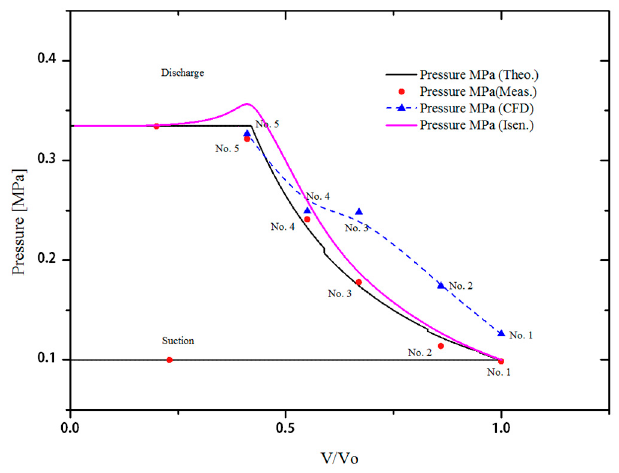
Figure 16. Comparison results of pressure distribution between the theoretical values, CFD and measurements on the p-V indicator diagram.